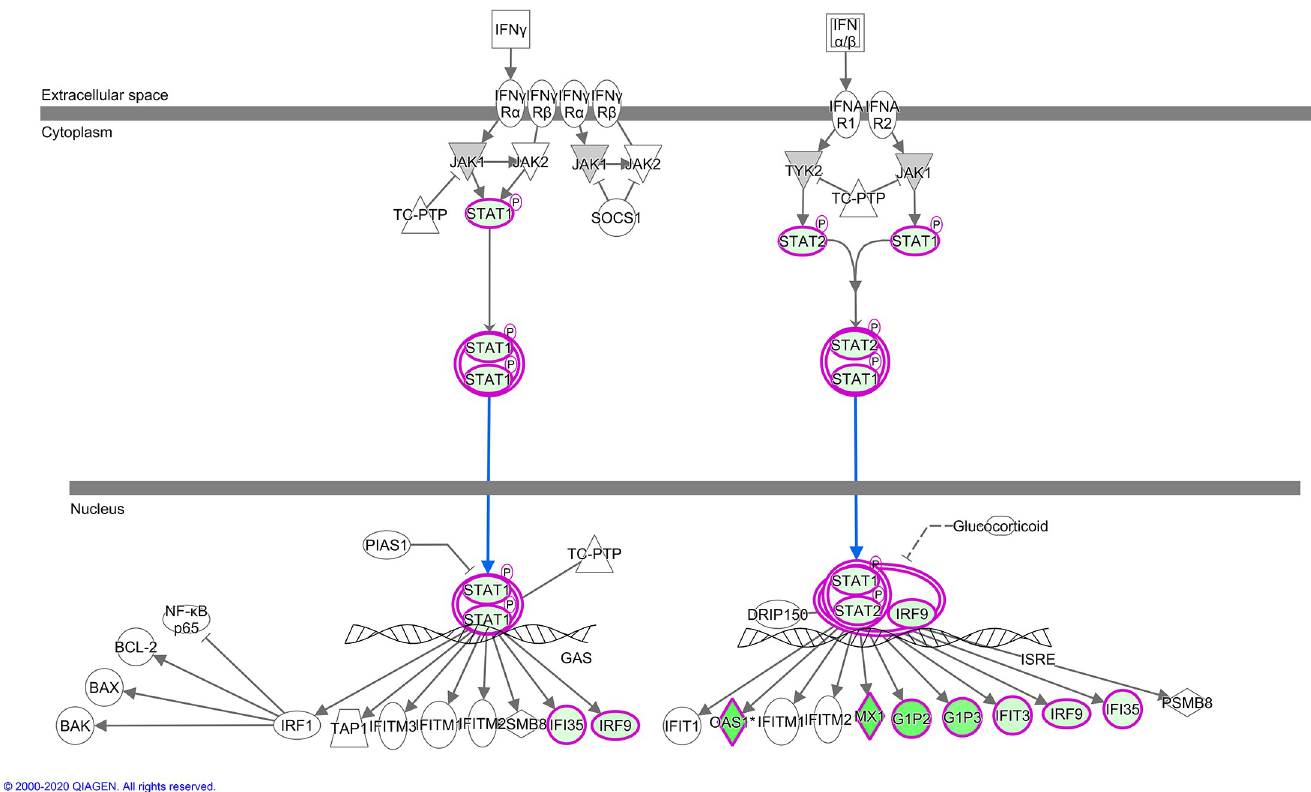
Fig 4. IPA canonical pathway, “Interferon